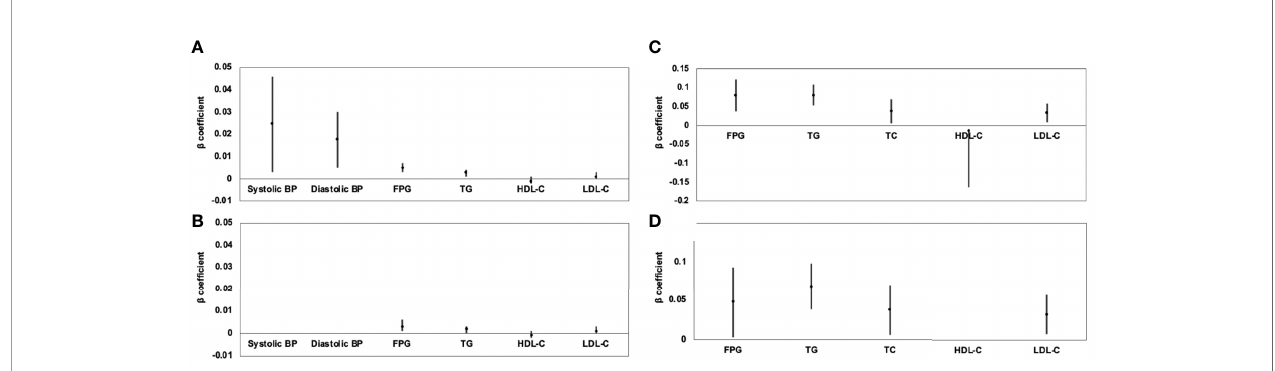
FIGURE 2 | Association of VAT area (A) and hepatic FF (C) with continuous cardiometabolic risk factors and further adjustment for BMI (B, D) expressed by b - coef fi cients and 95% con fi dence intervals. For all patients, higher VAT area was associated with higher systolic BP, higher diastolic BP, higher FPG, higher TG, lower HDL-C, and higher LDL-C (A) ; after further adjustment for BMI, these correlations continued to exist, except for systolic and diastolic BP (B) . Higher hepatic FF was associated with higher FPG, higher TG, higher TC, lower HDL-C, and higher LDL-C (C) ; after further adjustment for BMI, these correlations were still signi fi cant, except for HDL-C (D) .